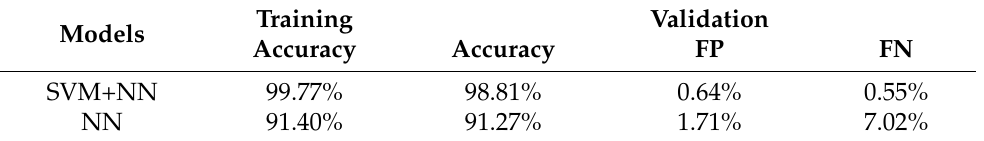
Table 5. Accuracy and false rates of restoring ground truth traces with or without SVM (Type-II dataset).